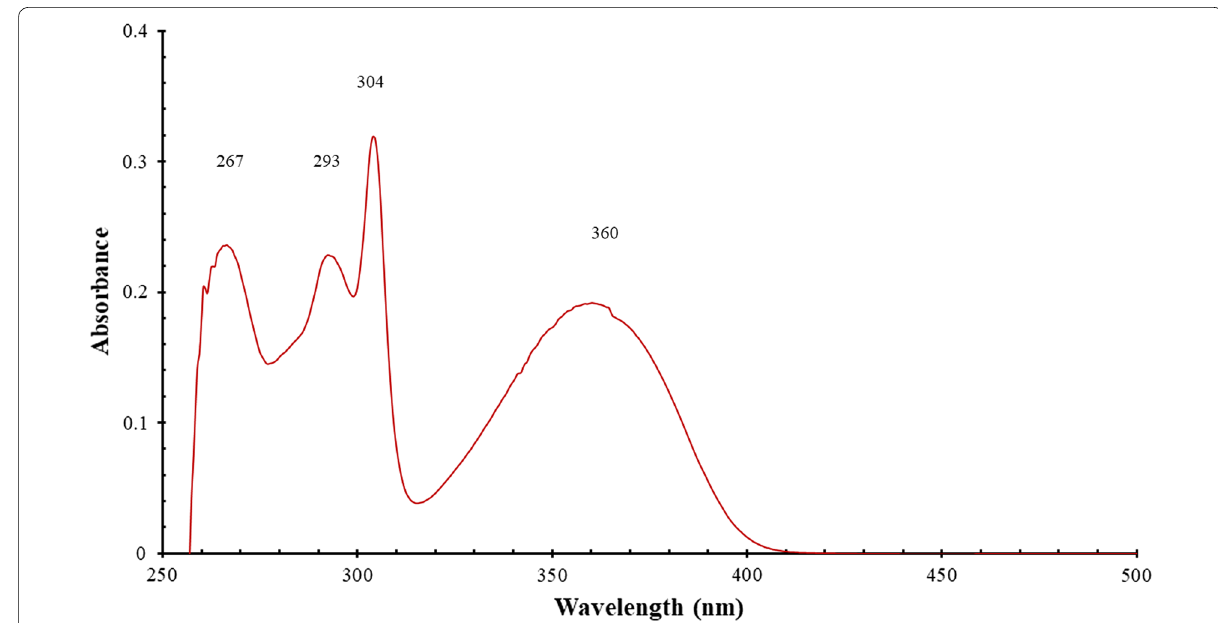
Fig. 6 UV–Vis spectrum of